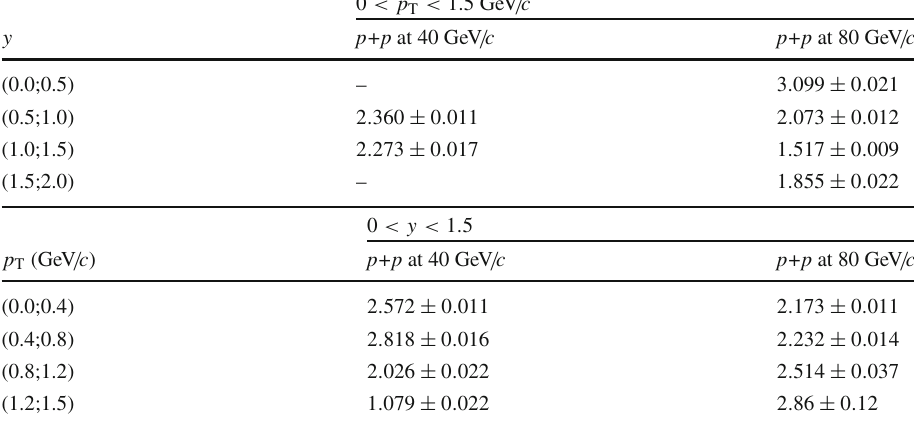
( y , p ) with statistical MC T uncertainties for 40 GeV / c (middle column) and 80 GeV / c (right column). Upper part: binning used to obtain y spectra of K ∗ ( 892 ) 0 (see Fig. 8). Lower part: binning used to obtain p T and m T spectra of K ∗ ( 892 ) 0 , as well as the p T dependence of